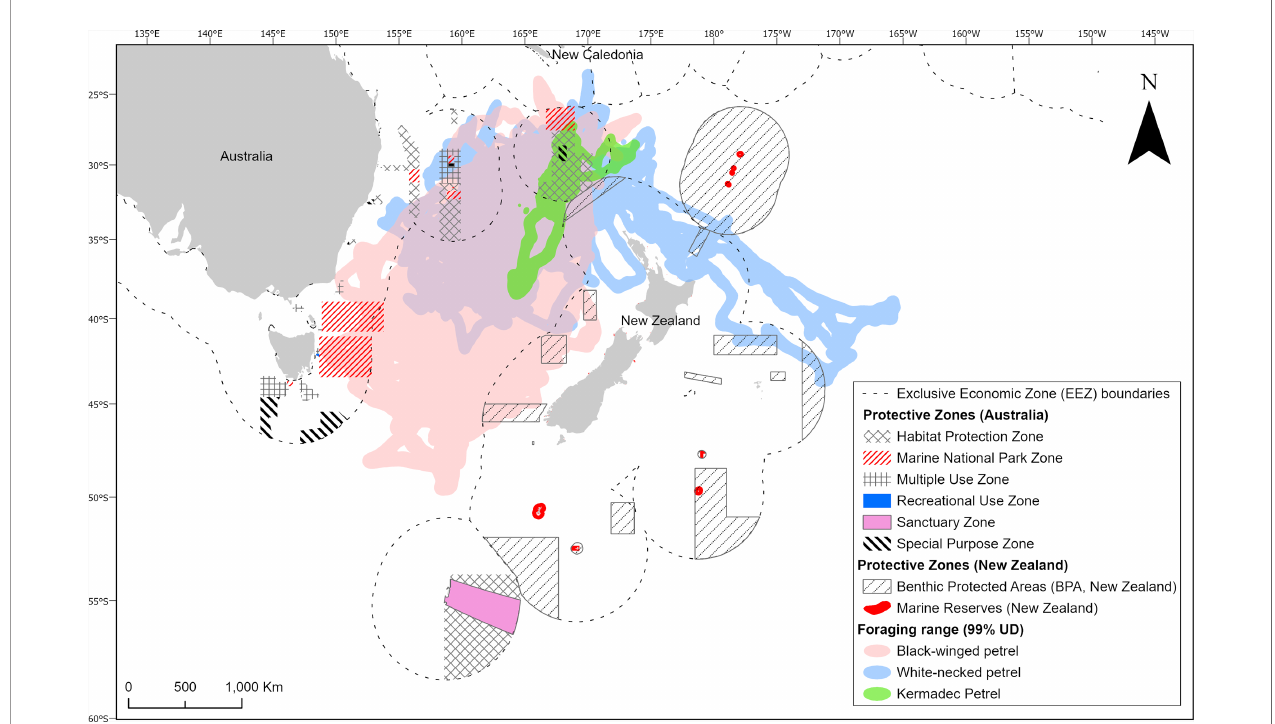
FIGURE 8 | Foraging ranges of black-winged petrels ( Pterodroma nigripennis ), white-necked petrels ( P. cervicalis ) and Kermadec petrels ( P. neglecta ) in relation to existing protected areas and areas outside of national